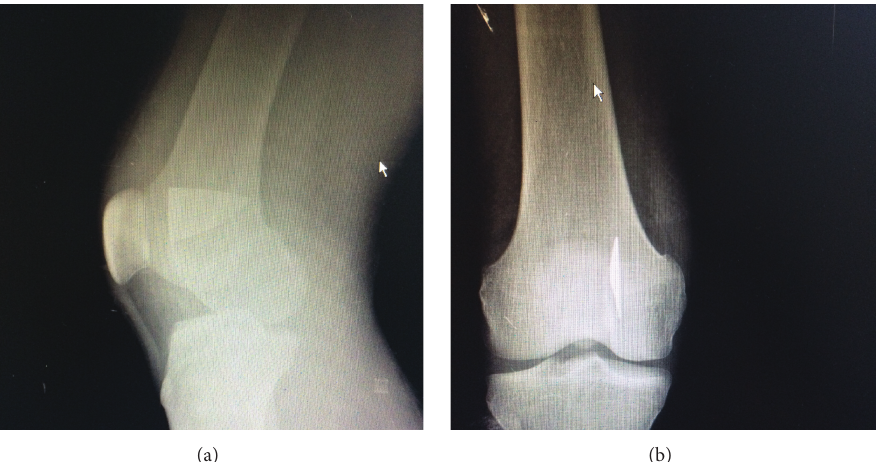
Figure 1: (a) Lateral radiographic examination of the knee. (b) Anteroposterior radiographic examination of the knee.